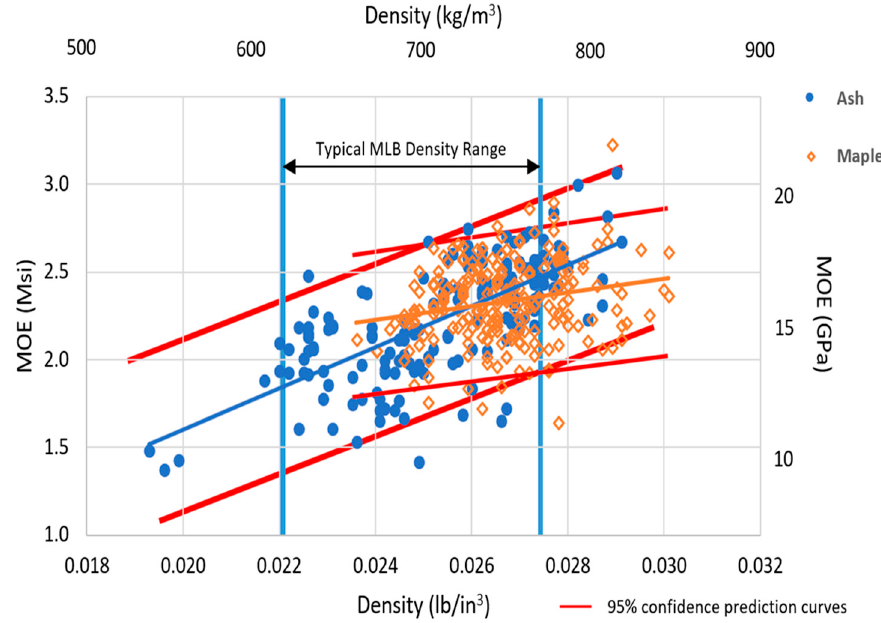
Figure 1. Modulus of Elasticity (MOE) test results for ash and maple dowels with slope-of-grain angles spanning the range of ±3°.